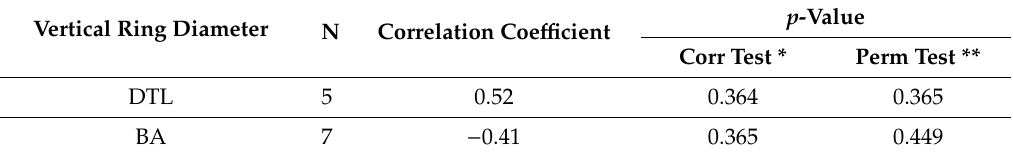
Table 8. Correlations between progression of 30 Hz flicker amplitude versus progression of vertical ring diameter.